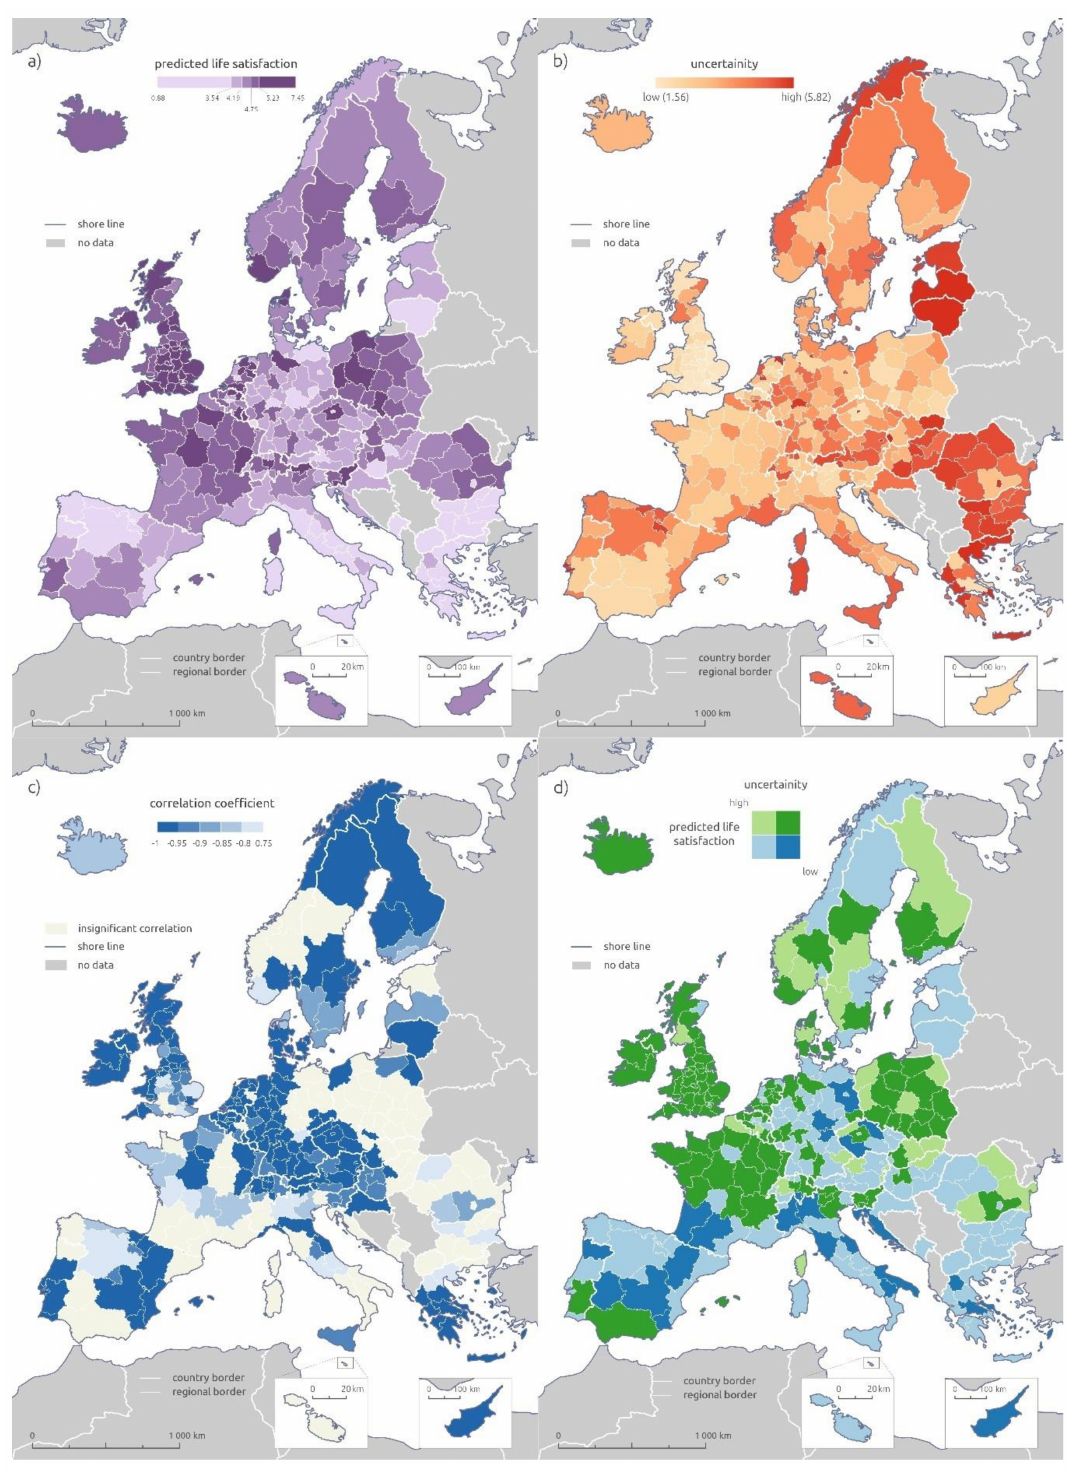
Figure 6. ( a ) Predicted values of life satisfaction at the NUTS 2 level ( b ) supplemented with the level of the prediction uncertainty, ( c ) the spatial variability of the relationship between uncertainty and predicted satisfaction as demonstrated by the geographically weighted correlation and ( d ) the typology based on uncertainty and predicted